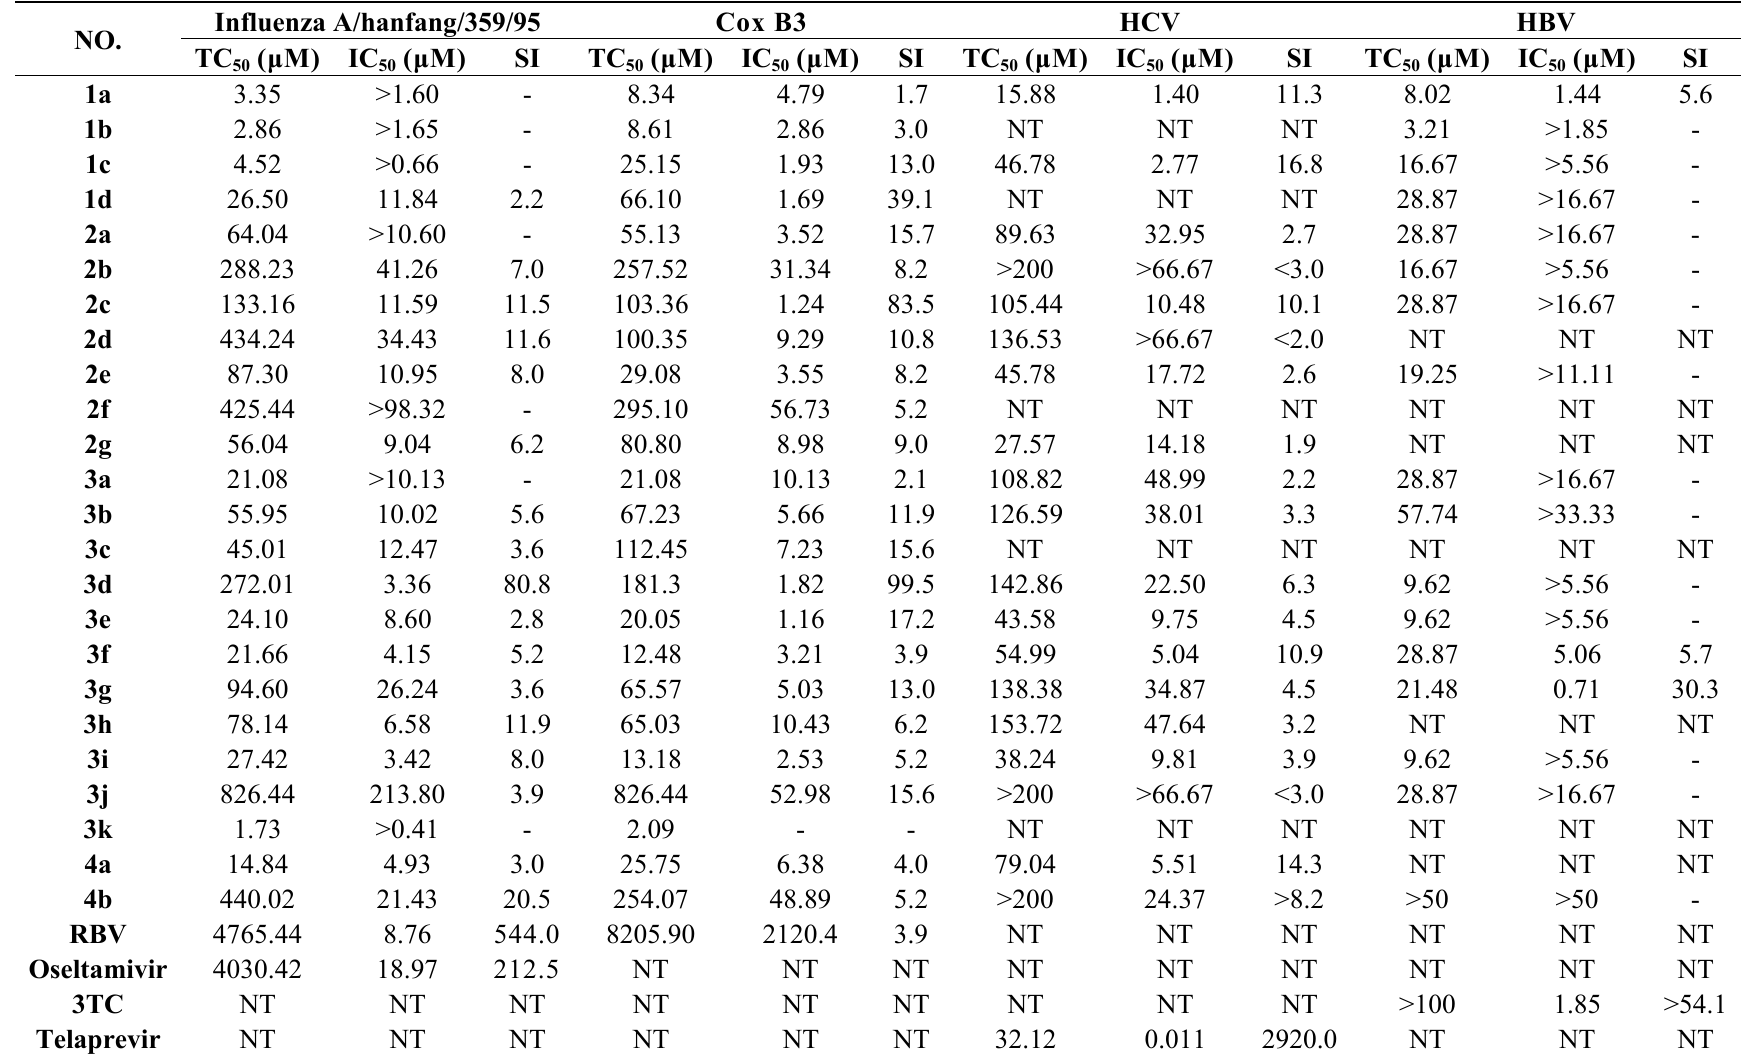
Table 1. The antiviral activity and cytotoxicity of the